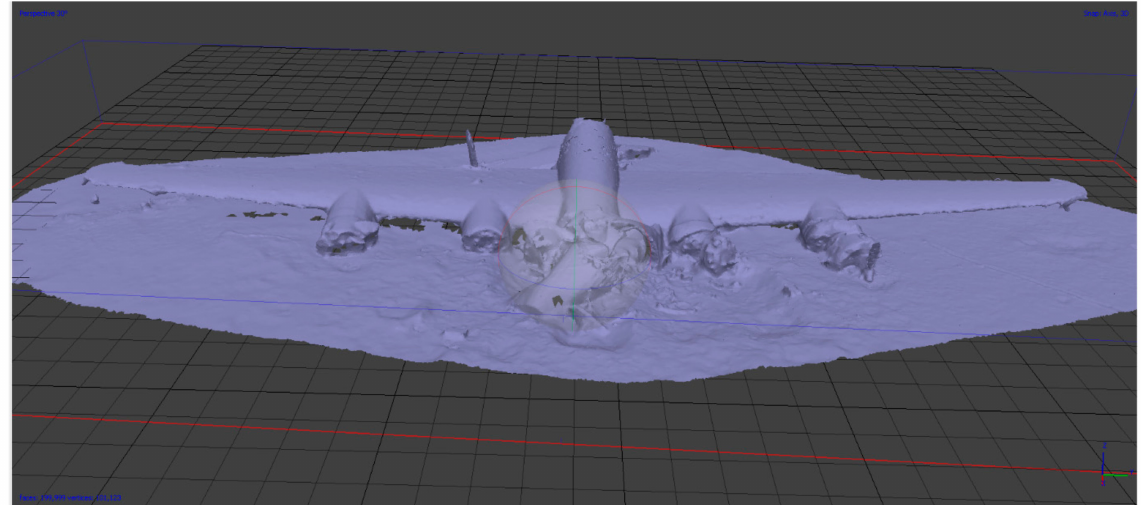
Figure 7. Mesh of the B24 Liberator wreck